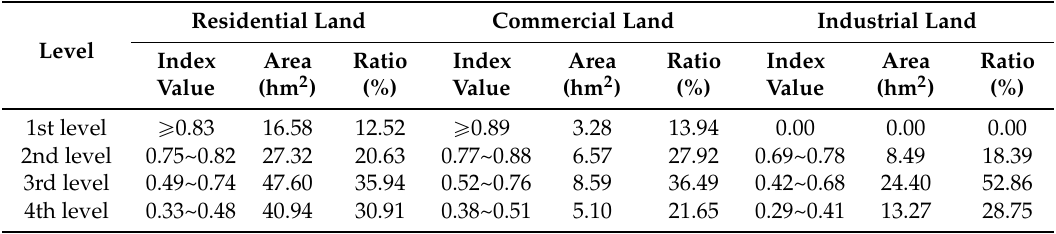
Table 3. Statistical analysis of the Voronoi polygon aggregation index for each land use